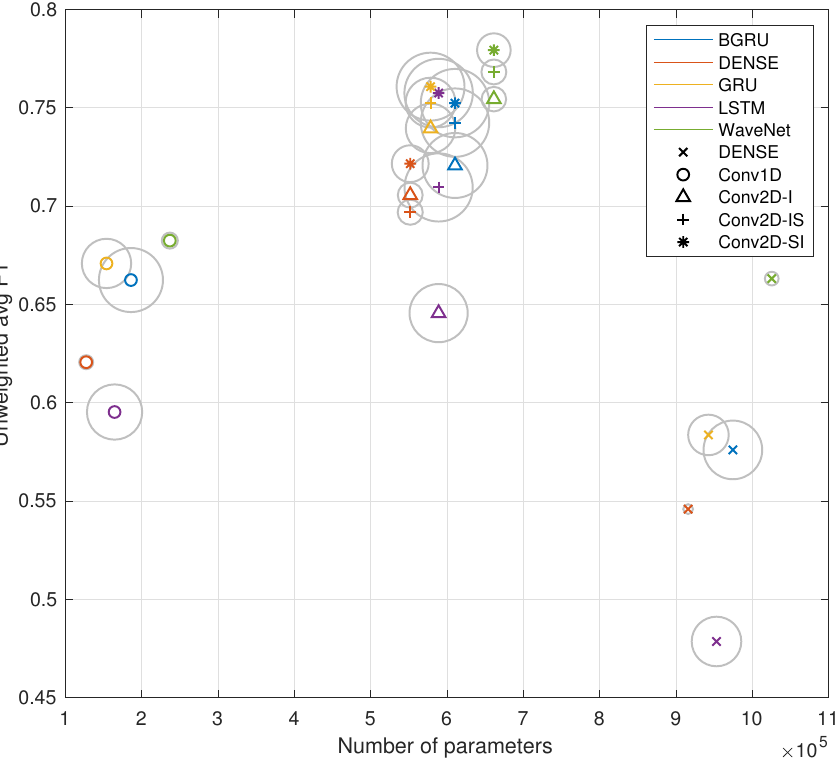
Figure 7. Average performance of trained systems as a function of model size (x-axis) and the generation time of the test set (symbol area).